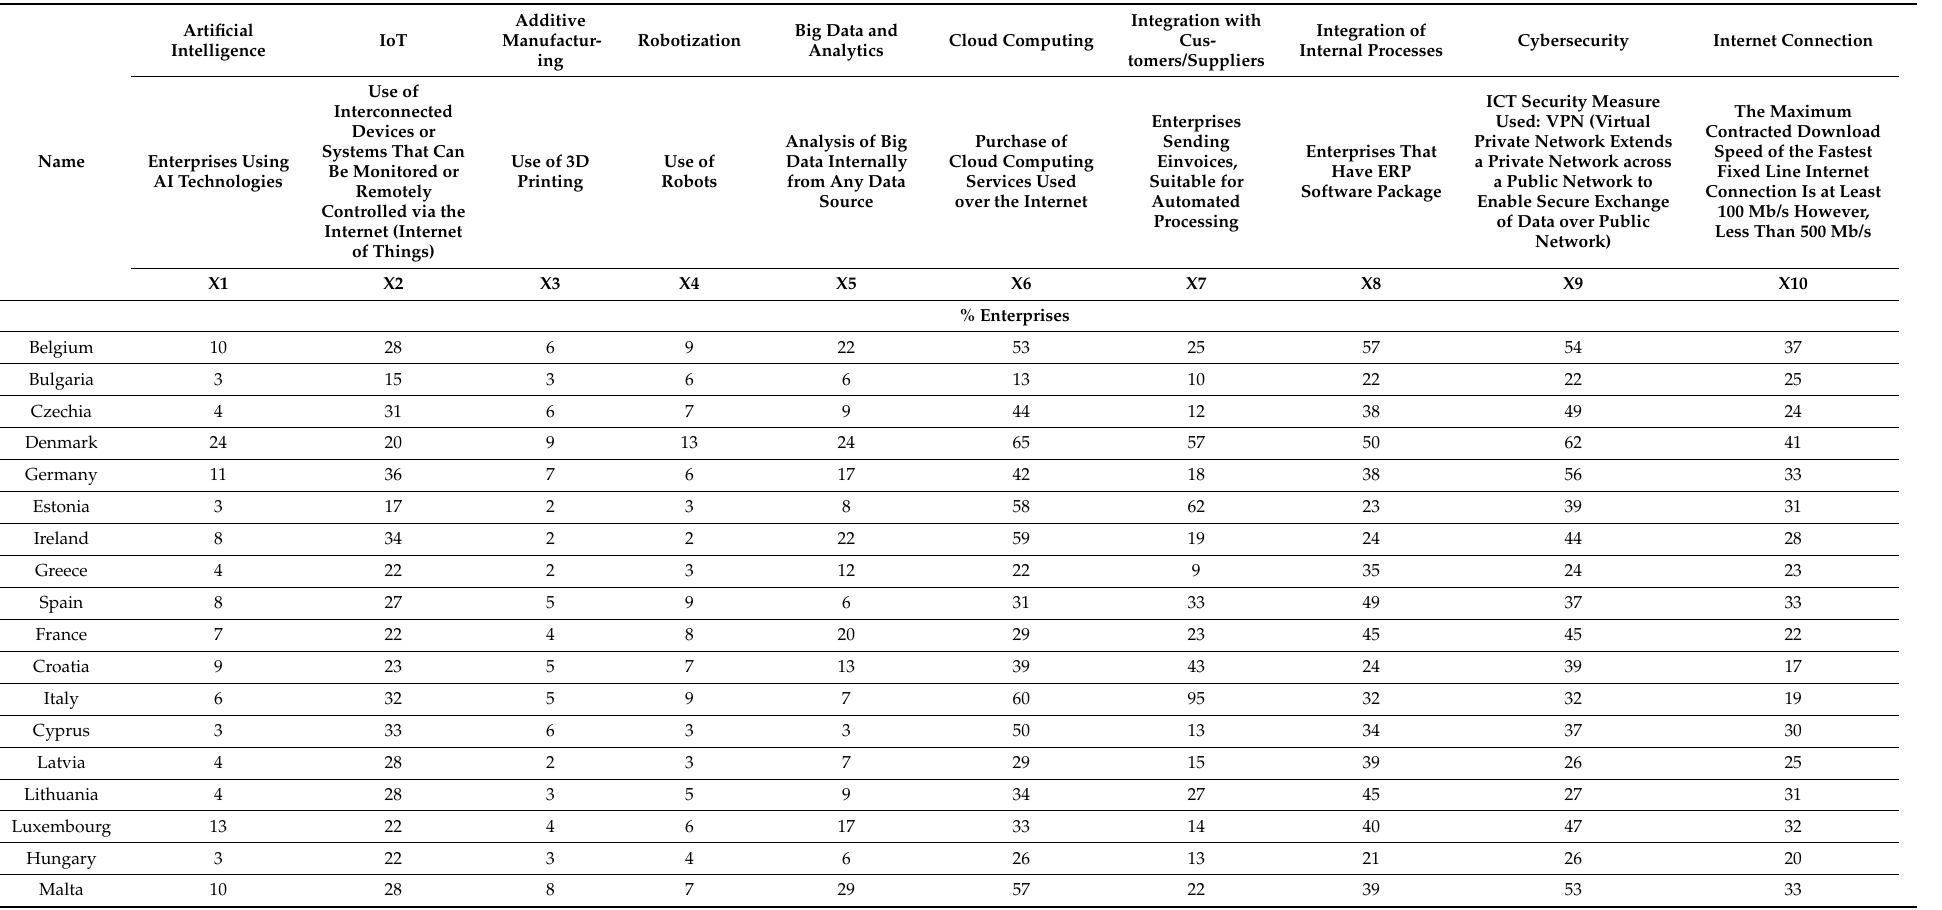
Table 2. The summary of values of indicators characterizing the use of digital technologies and applied infrastructure for Industry 4.0 among enterprises in individual EU-27 countries (own elaboration based on